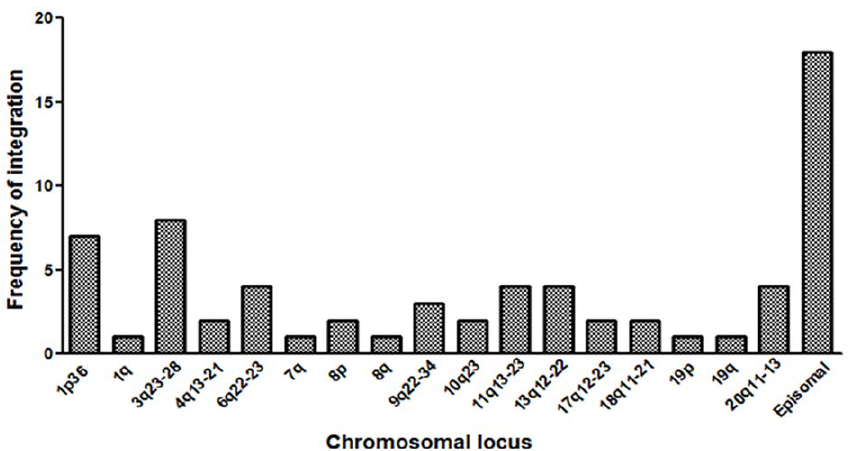
Figure 4. Frequency of HPV integration into different chromosomal loci. Site of integration as determined by APOT assay in 48 cases positive for HPV16, HPV18 or both and with high prediction score using BLAST/BLAT. Integration event was found to be more common in 1p and 3q chromosomal loci. Each bar represents different chromosomal locus.